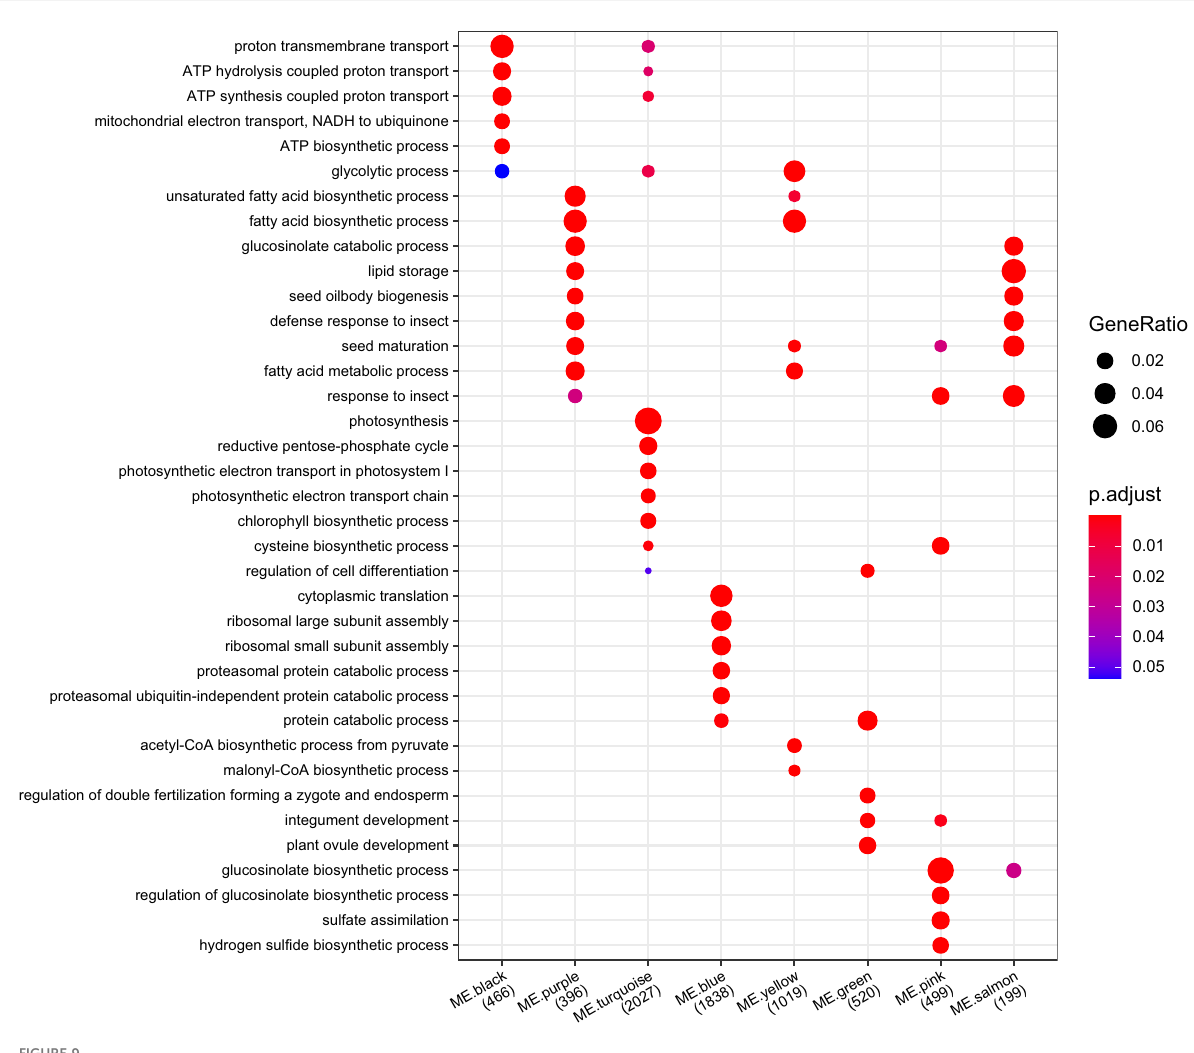
FIGURE 9 Comparing GO functional pro fi les of 22 module eigengenes. The top 3 GO enriched biological process of each module were displayed, and other results were listed in Supplementary Table 18. The numbers under each module were counts of genes annotated by